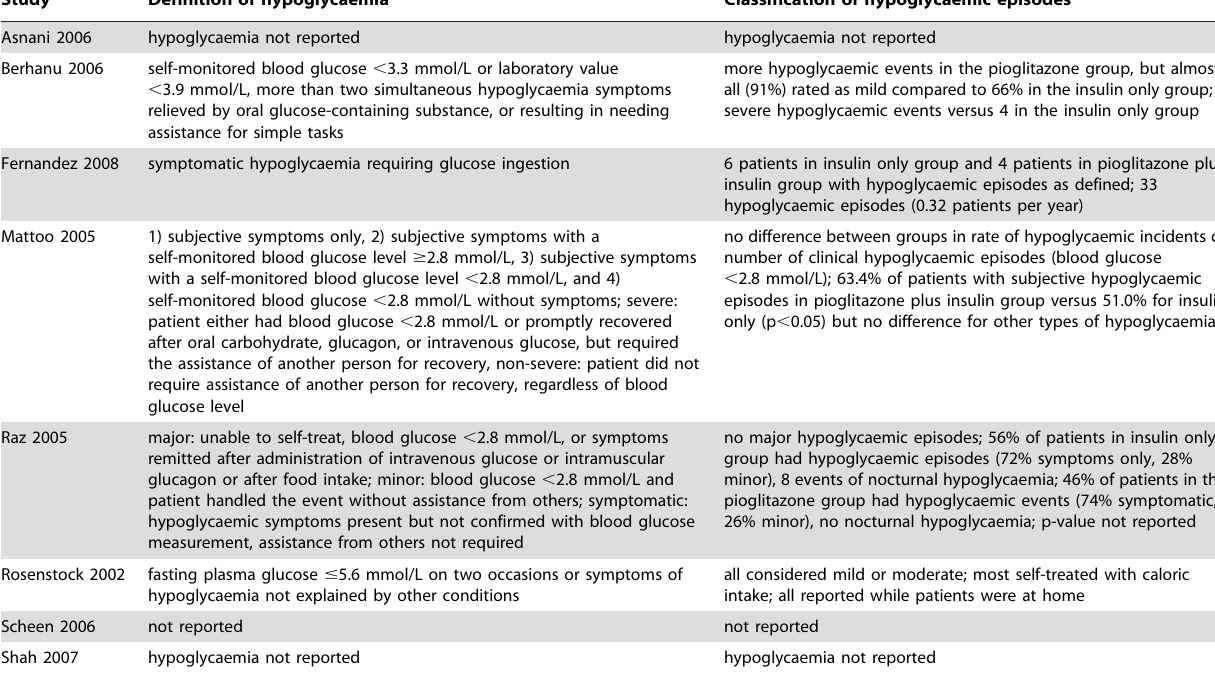
Table 4. Details of hypoglycaemic